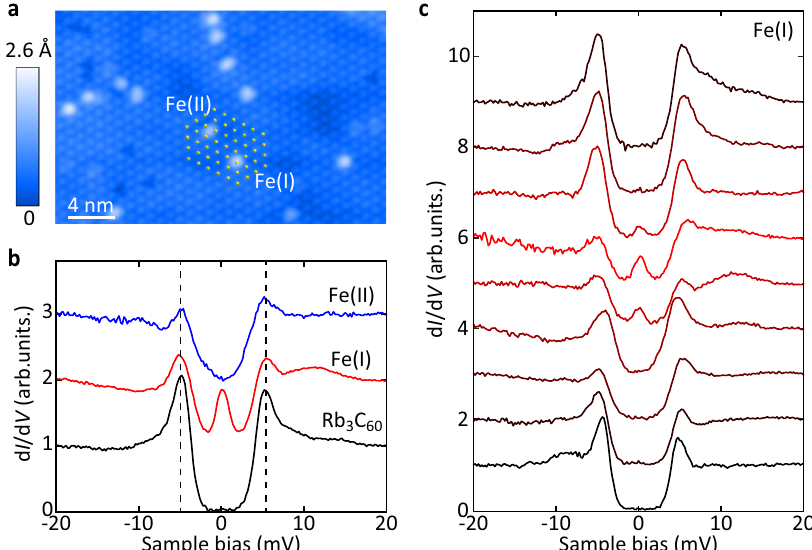
Fig. 4 Magnetic impurity (Fe)-induced bound states. a STM topography (28 nm × 18 nm, V = 2.0 V, I = 30 pA) of superconducting Rb 3 C 60 fi lms upon intentional post-deposition of tiny Fe adatoms. The yellow dots indicate the topmost C 60 molecules. b Comparison of tunneling conductance d I /d V spectra averaged over single Fe(I), Fe(II) impurities, and locations far from any impurities. Black vertical dashes denote the energy positions of the superconducting gap. c Linecut d I /d V spectra taken at equal separations (0.7 nm) across an isolated Fe(I) impurity. The red curve is measured justly on the impurity site. Setpoint: V = 30 mV and I = 200